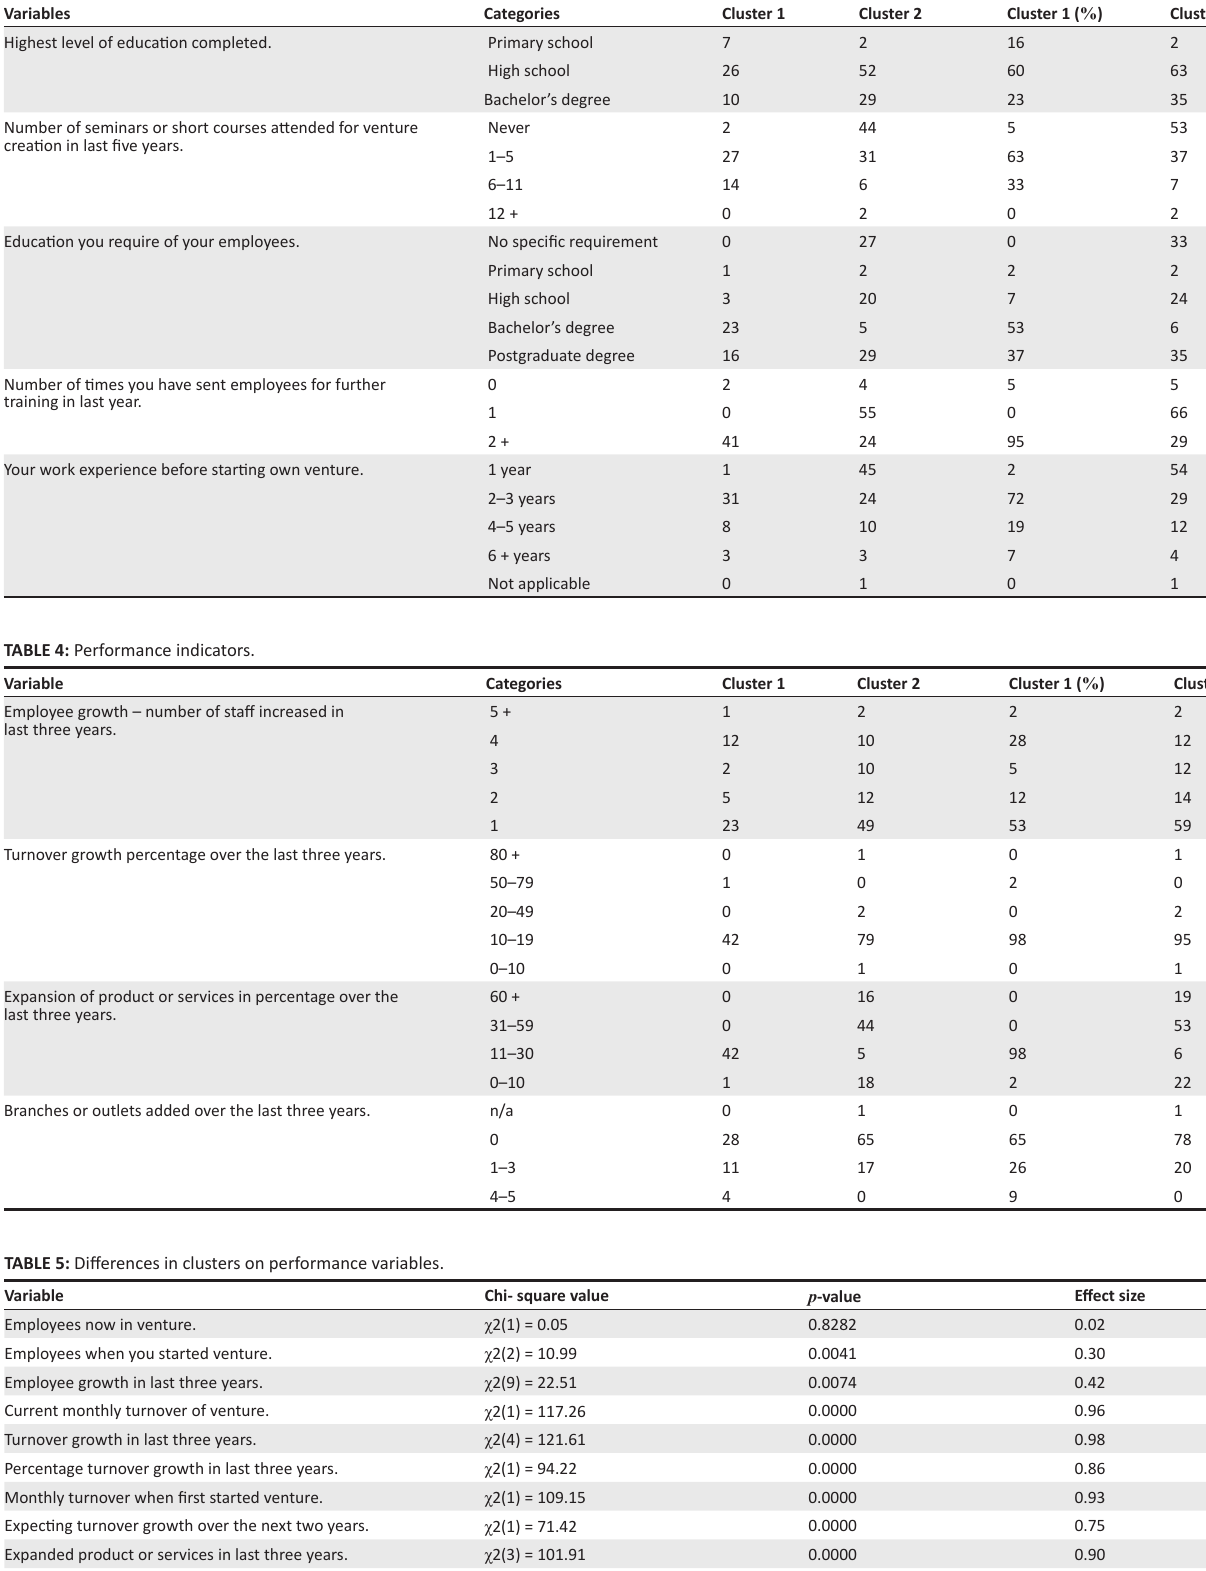
TABLE 3: Types and levels of education and work experience. Variables Highest level of education completed.